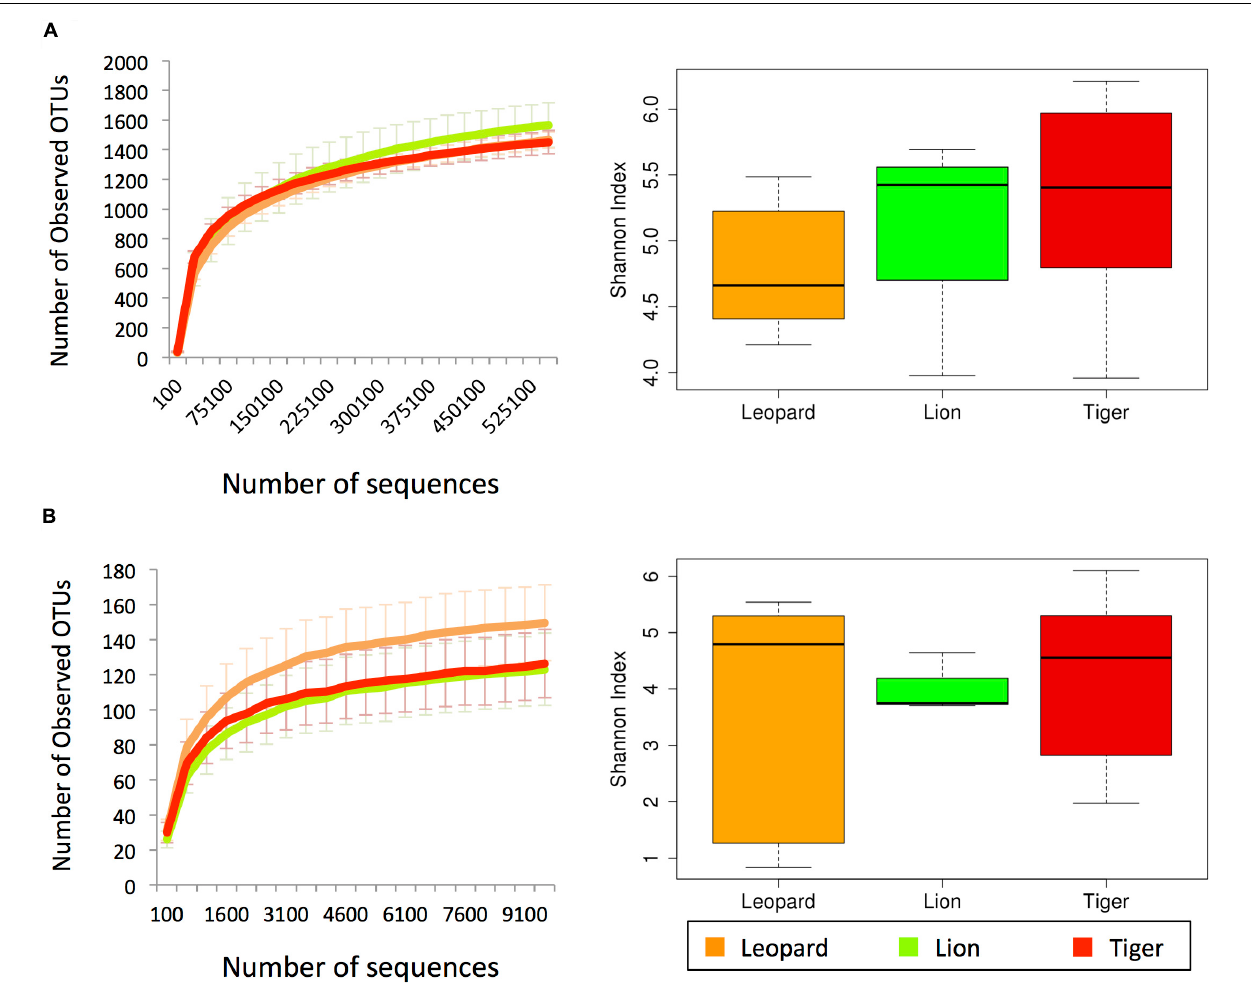
FIGURE 1 | The alpha diversity estimates from (A) V3 hypervariable region of 16S rRNA and (B) ITS-1 amplicon sequences. The left charts show the rarefaction curves of the number of observed operational taxonomic units (OTUs) with respect to the number of sequences. The box plots in the right show the Shannon index estimates using the maximum number of